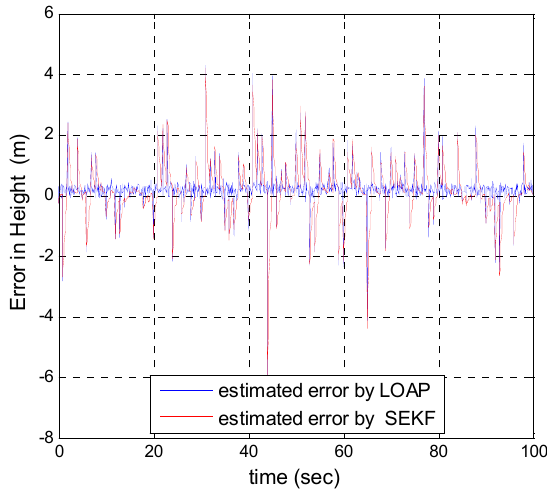
Figure 8. Error estimation of east velocity.